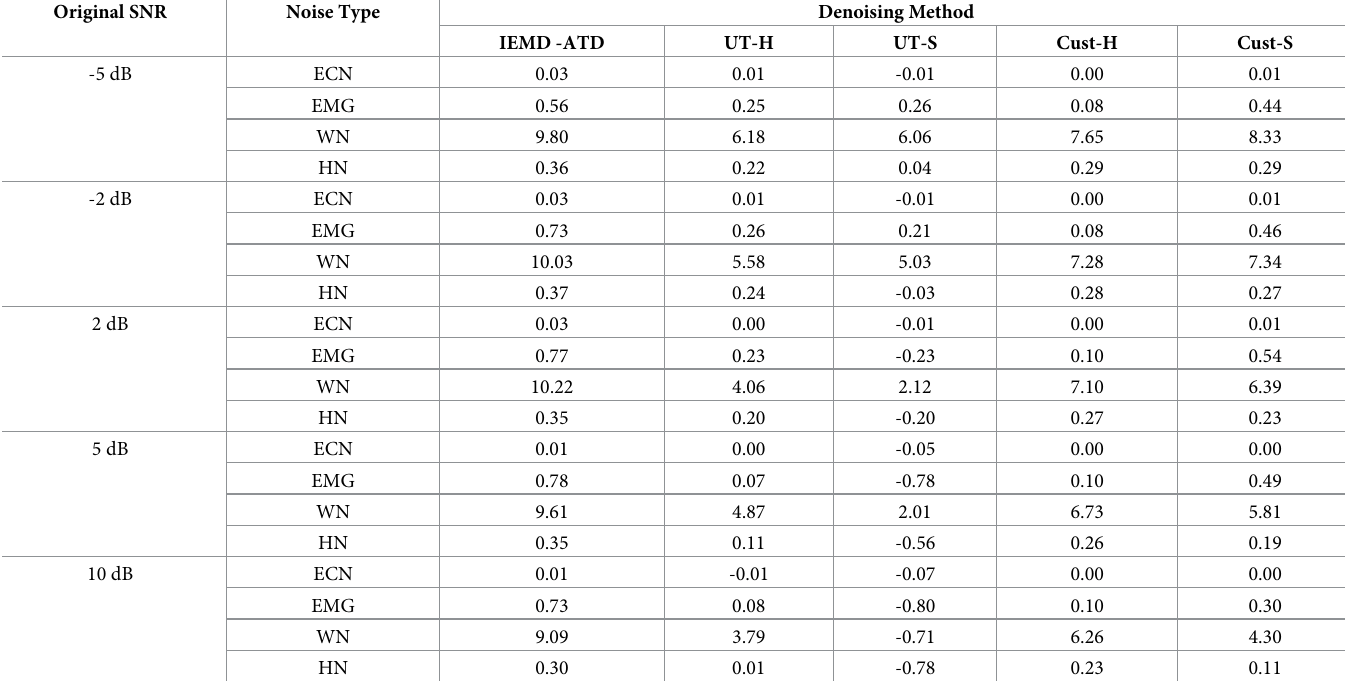
Table 8. Average SNR improvement of 6 synthetic ECGs (Syn00-Syn05) for eliminating only high-frequency noise.